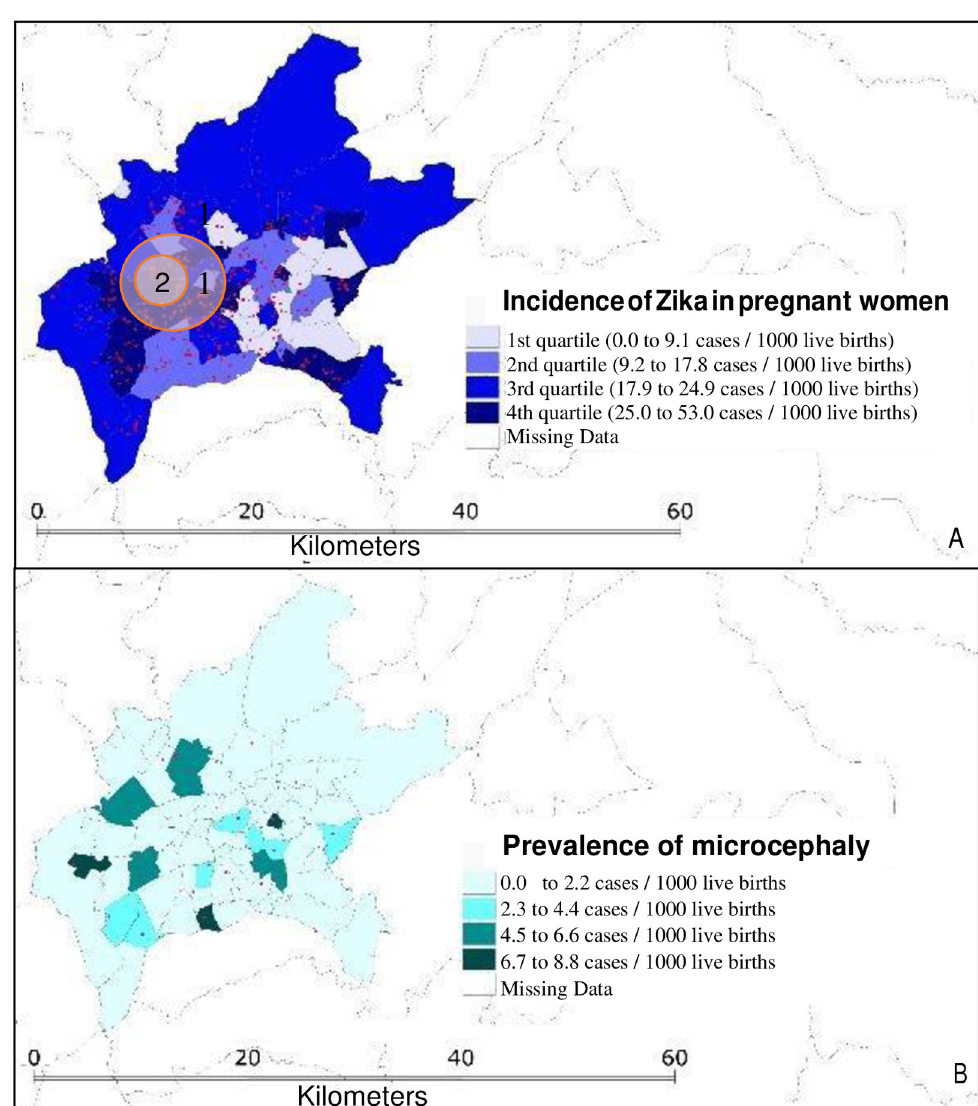
Fig 3. A- Cases and quartiles of incidence of Zika virus infection (ZIKVi) in pregnant women according to the census sub-district of the city of Goiania (2016/2017). B- Cases and quartiles of prevalence of microcephaly according to the census sub-district of the city of Goiania (2016/2017). 1 –Spatial cluster of high risk of ZIKVi in pregnant women, 2016. 2 –Spatial cluster of high risk of ZIKVi in pregnant women, 2017.